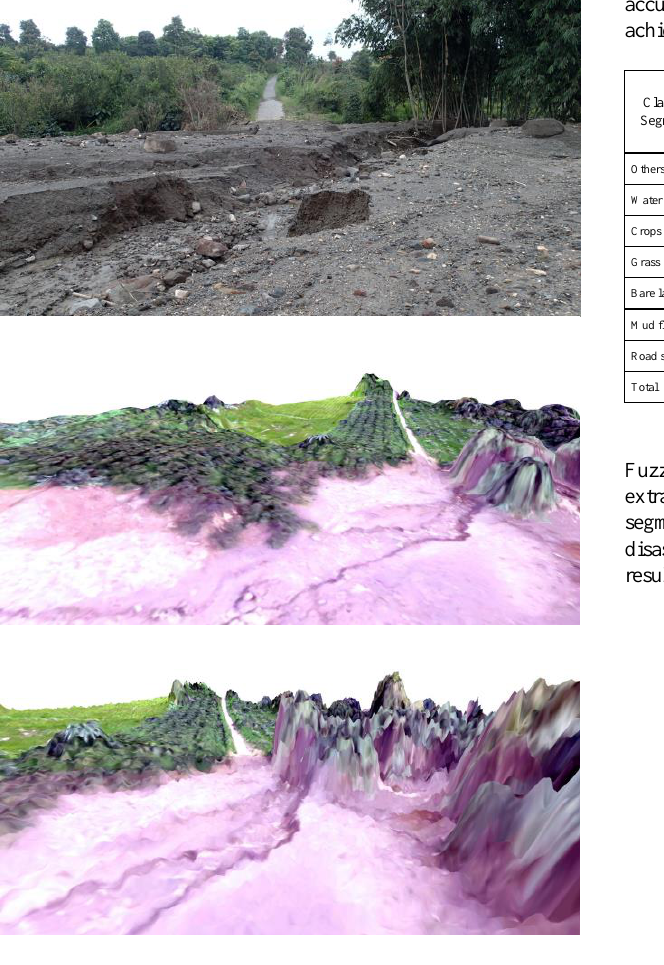
Figure 5: 3 D Field verification (upper: field survey, middle: Agisoft Photo Scan, lower: PCI Geomatics)